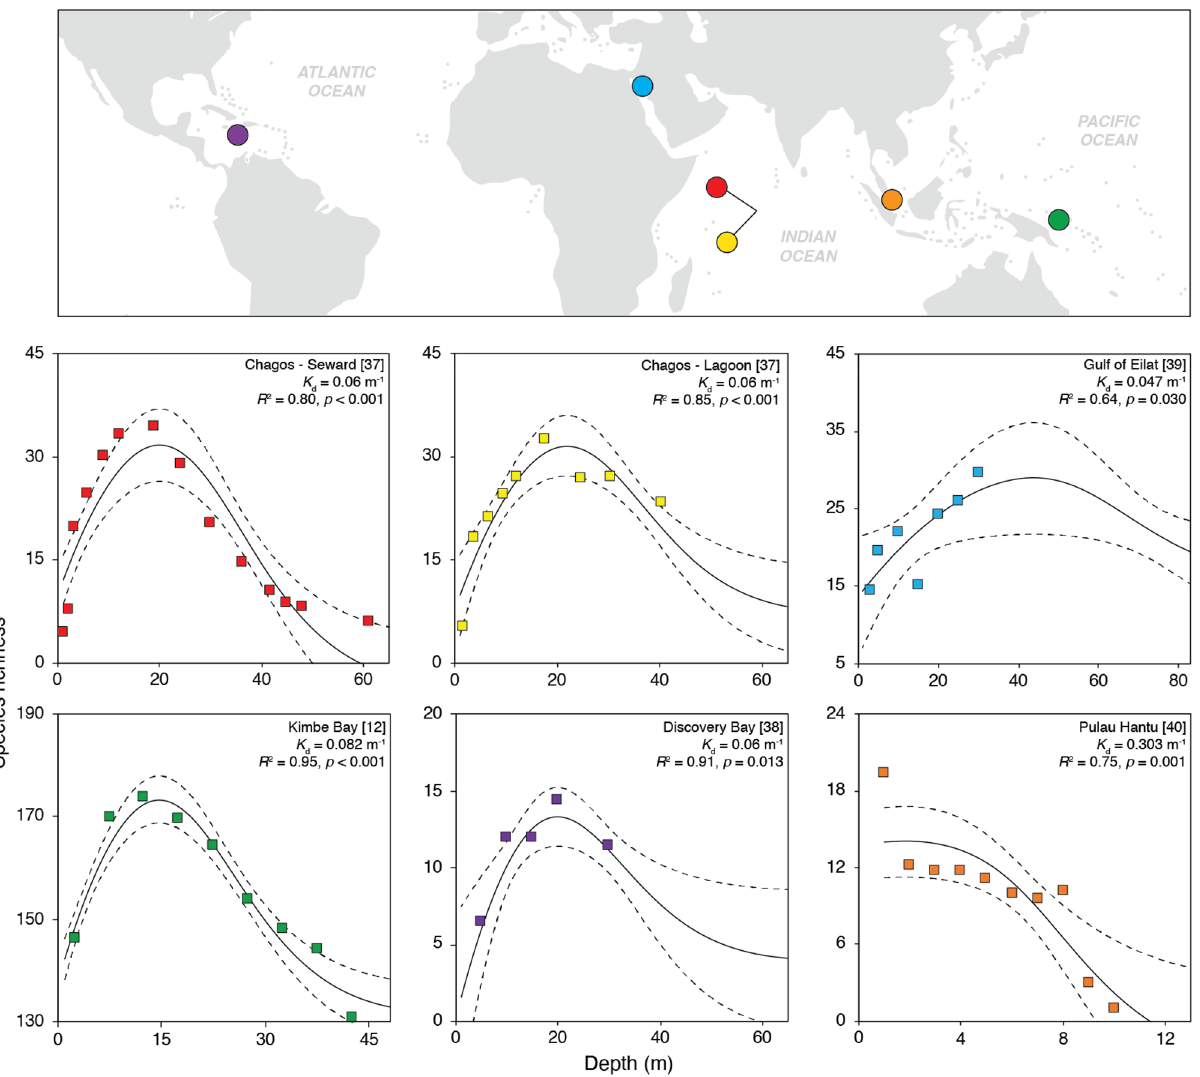
Figure 2. Coral species richness variation along depth gradients in reefs from major hotspots of biodiversity. The observed distribution of species richness (squares) is significantly explained by the coral productivity- biodiversity model at all sites. Continuous lines represent the trend in mean values and the discontinuous lines 95% confidence intervals. The goodness-of-fit ( R 2 ) and the statistical significance of the model ( p -value), together with the local K d are indicated for each site. Species richness was projected to depths at which the light intensity was estimated to be 2% of the incident irradiance at sea